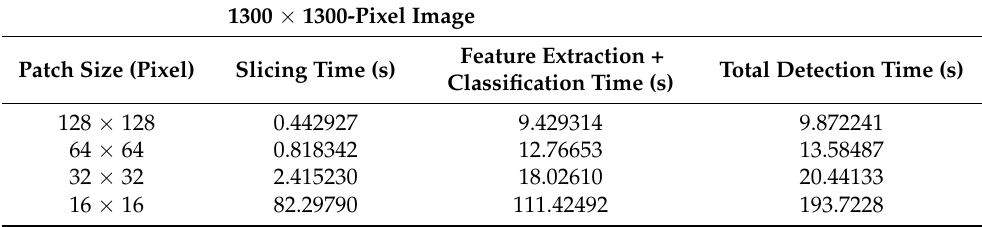
Table 2. SVM kernel parameter optimization.